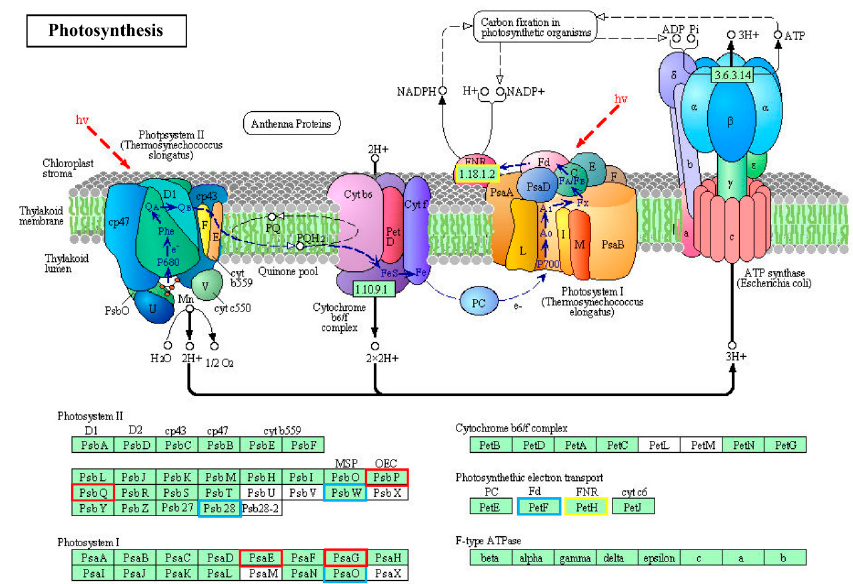
Figure 8. The “photosynthesis” pathway enriched by KEGG analysis of DE mRNA corresponding genes in the cultivar “Huoche” under heat stress. KO nodes containing up-regulated genes are marked with red boxes, while KO nodes containing down-regulated genes are marked with blue boxes. PsbP, photosystem II oxygen-evolving enhancer protein 2; PsbQ, photosystem II oxygen-evolving enhancer protein 3; PsbW, photosystem II PsbW protein; Psb28, photosystem II 13kDa protein; PsaE, photosystem I subunit IV; PsaG, photosystem I subunit V; PsaO, photosystem I subunit PsaO; PetF,